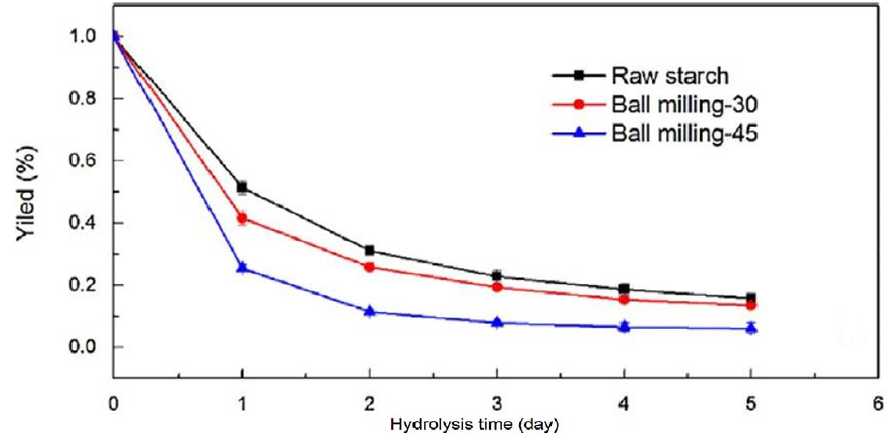
Figure 12. The yield % of hydrolyzed starches as a function of ball milling times (0, 30 and 45 min) during the 1–5 days of hydrolysis’s period [102]. (RightsLink License obtained to use this Figure from CCC, Copyright Clearance Center, Carbohydrate Polymers).